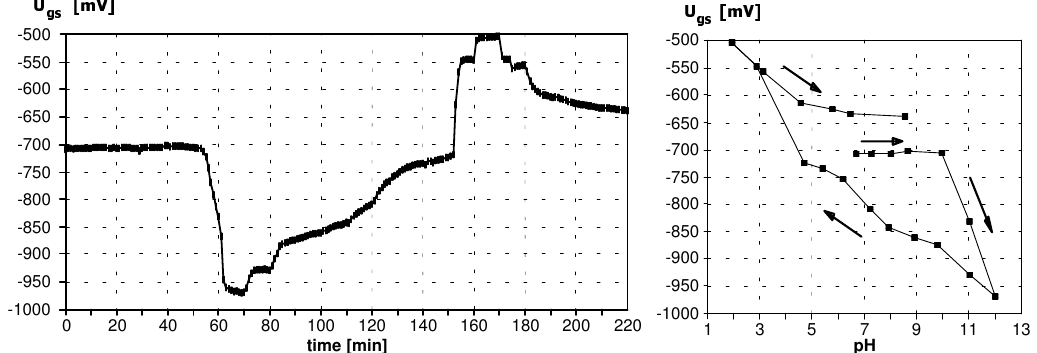
Figure 2. Dynamic response and calibration curve to pH of an ISFET with polyHEMA coating deposited according to the Method 2, with subsequently increased thickness by dropping of additional portion of HEMA by means of micropipette. Cycle of pH changes: 6.5-12-2-8.5.